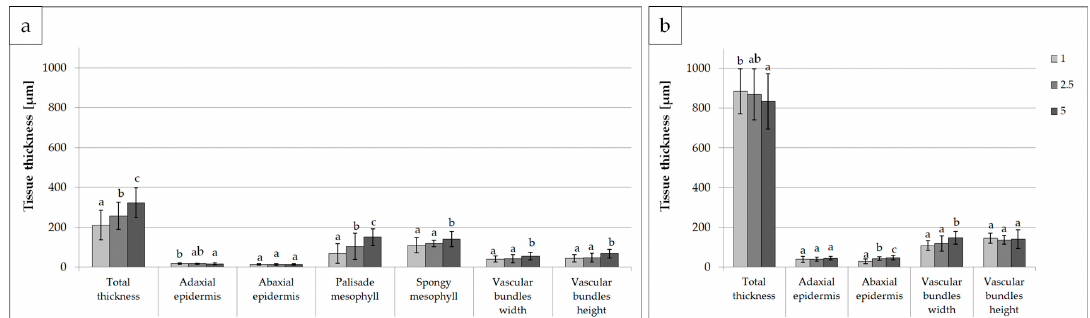
Figure 4. Characteristics of gerbera leaf anatomy: ( a ) blade and ( b ) petiole structure after 6 weeks of in vitro cultivation of shoots depending on the quality of light; B — 100% blue LED; RB — mixed red and blue LED (7:3); R — 100% red LED; Fl — control, white fluorescent lamp; tissue thickness in µm; mean values are presented with standard deviation bars; columns followed by the same letter are not significantly different according to Duncan’s multiple range test at p ≤ 0.05.